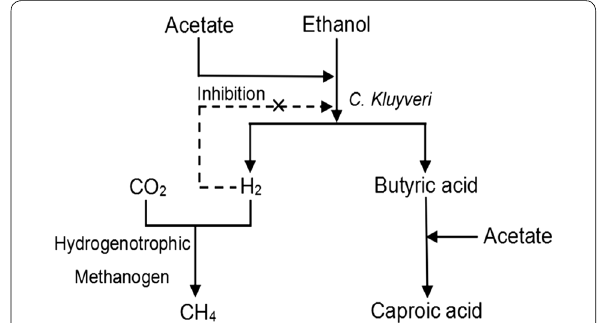
Fig. 7 The synthesis metabolic frame of caproic acid during the co-culture